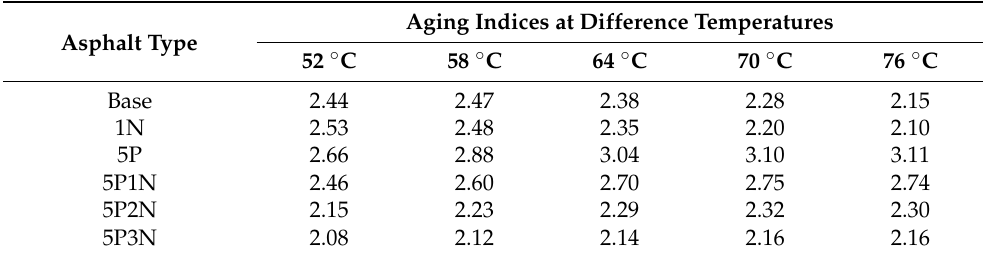
Table 7. AIR values approximated for various types of asphalt at different